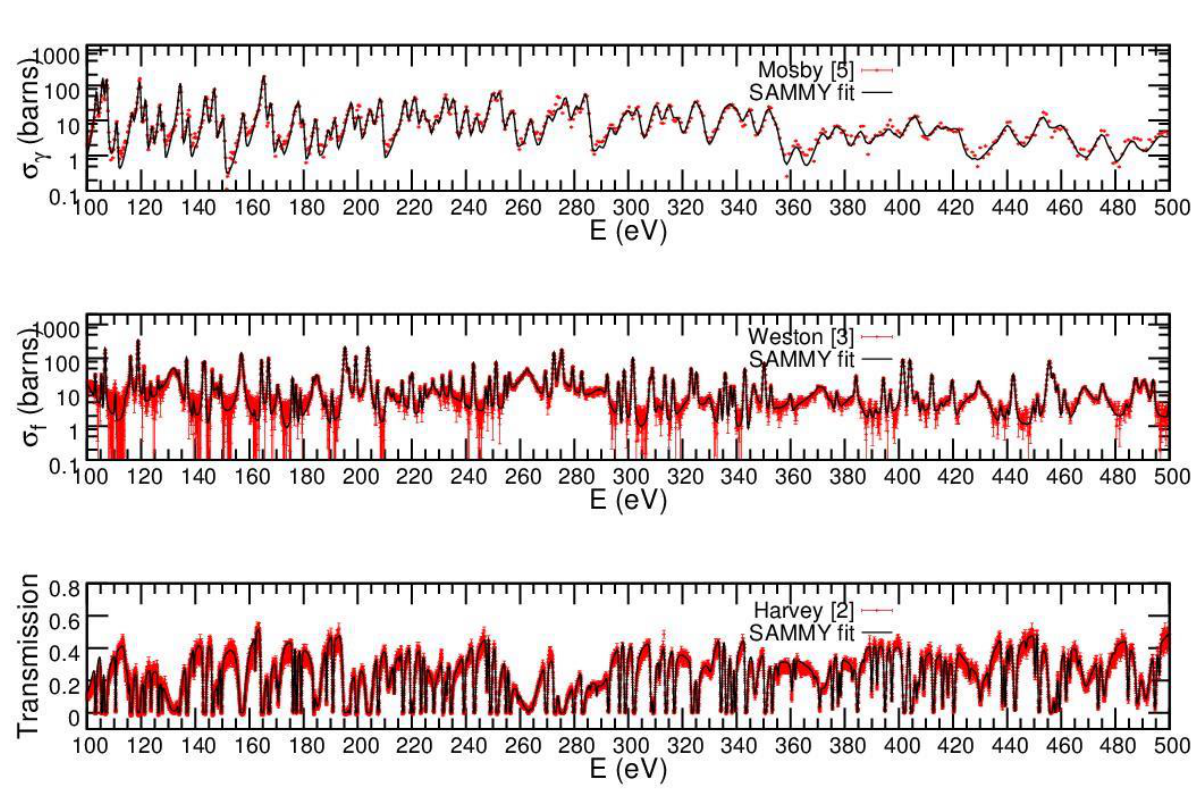
Figure. 2. SAMMY fit of the Harvey transmission data (bottom), Weston fission cross section data (middle) and Mosby capture cross section data (top).